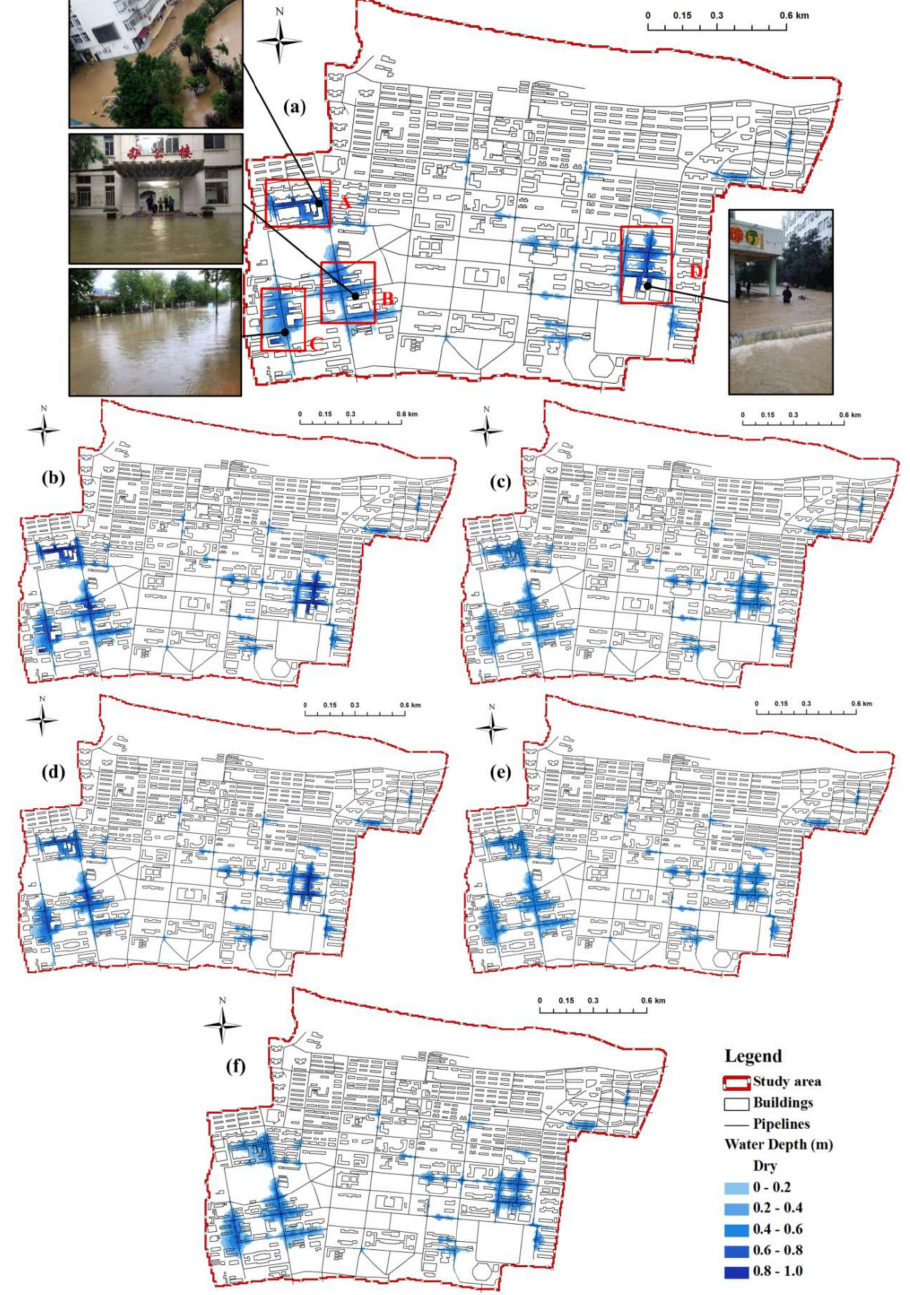
Figure 13. Maximum flood area and inundation depth simulated by the models using different building treatments: ( a ) BB Method; ( b ) BH method; ( c ) IBTA0.4 method; ( d ) IBTA0.6 method; ( e ) IBTA0.4R method; and ( f ) BR